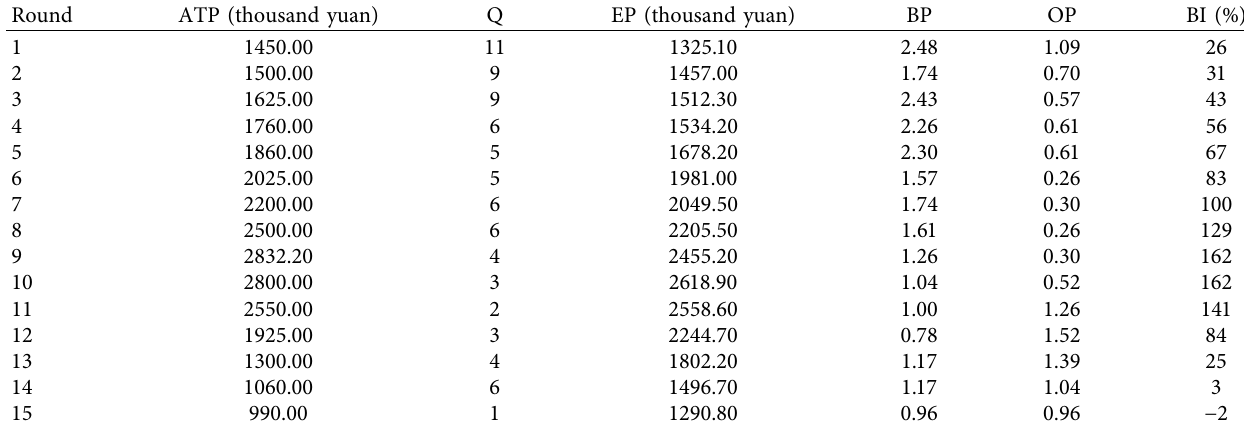
Table 4: Statistical indicators of high deposit interest rate group.